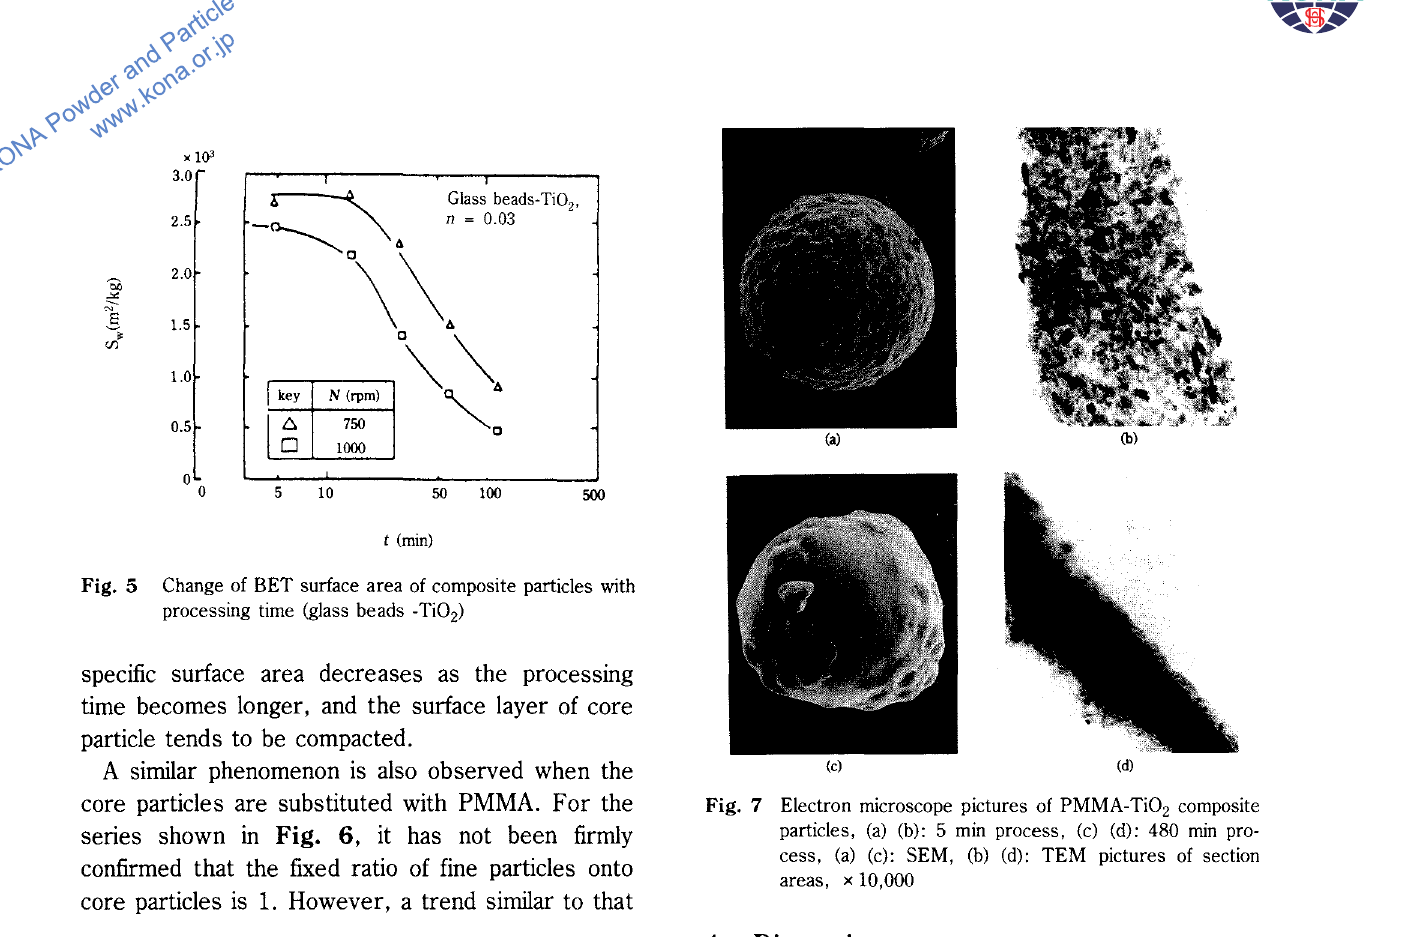
Fig. 6 Change of BET surface area with processing time CPMMA-Ti0 2 )